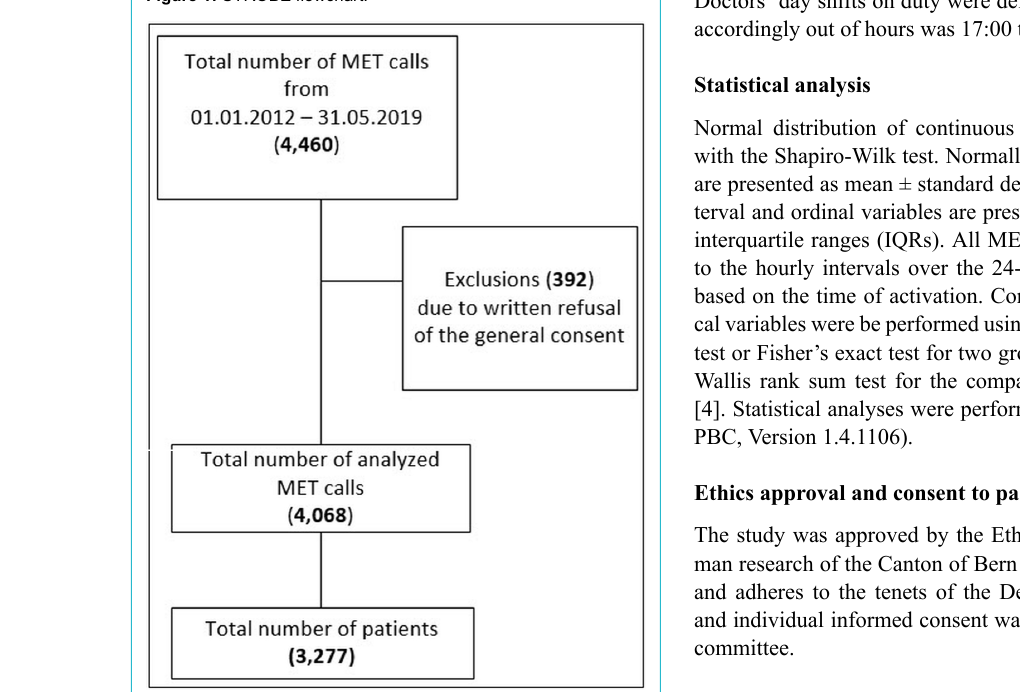
Figure 1: STROBE